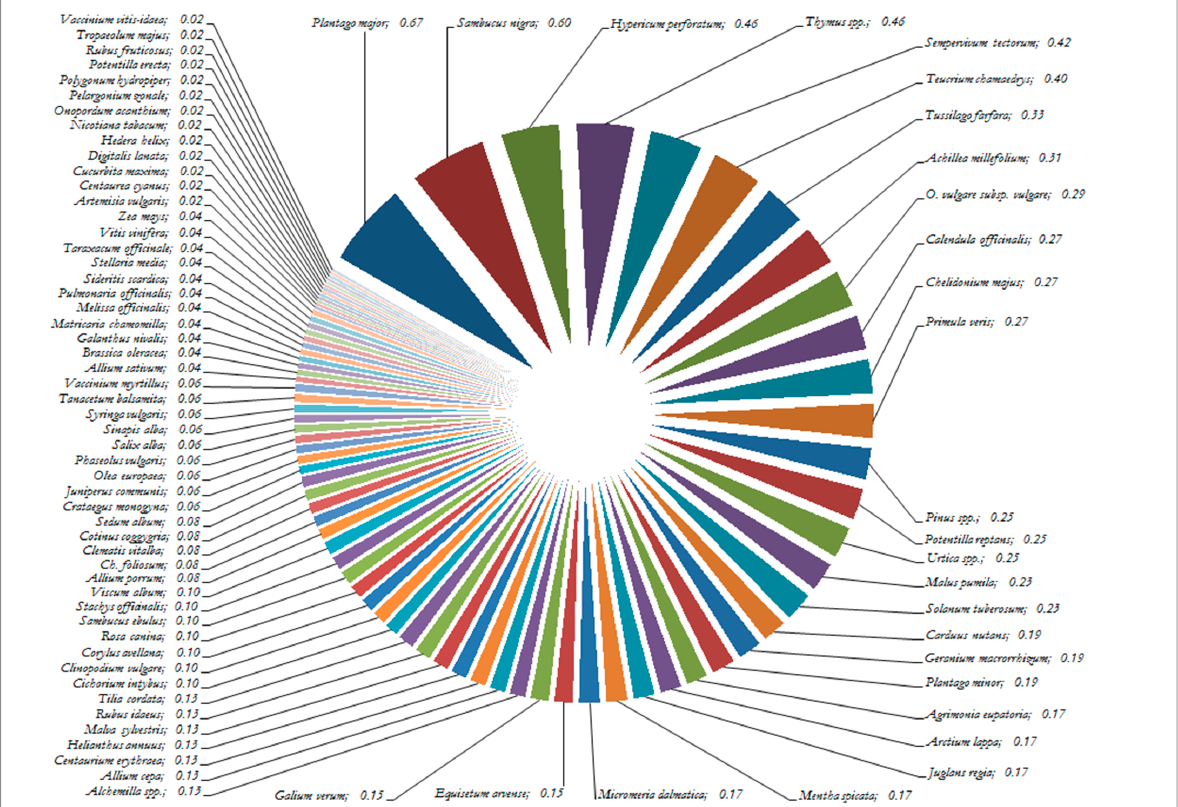
Figure 8. Plant species used for human health conditions in Central Rhodopes according to the value of the UV index. of the UV